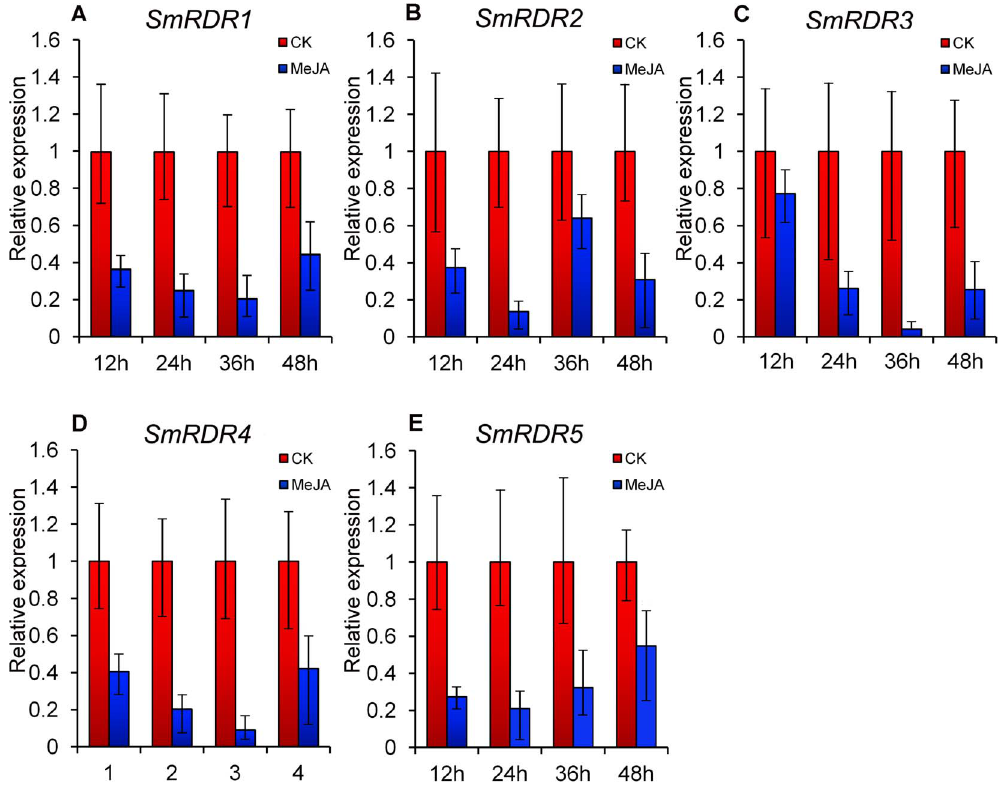
Figure 7. SmRDRs responsive to MeJA treatment. The expression patterns were analyzed using the quantitative RT-PCR method. PCR was carried out in triplicates for each biological sample. Three independent biological replicates were performed. SmUBQ10 was used as a reference. Fold changes of SmRDRs in leaves of S. miltiorrhiza plantlets treated with MeJA for 12, 24, 36 and 48 h are shown. The level of transcripts in leaves treated with sterile water (CK) was arbitrarily set to 1 and the level in tissues treated with MeJA was given relative to this. Error bars represent standard deviations of mean value from three biological replicates.